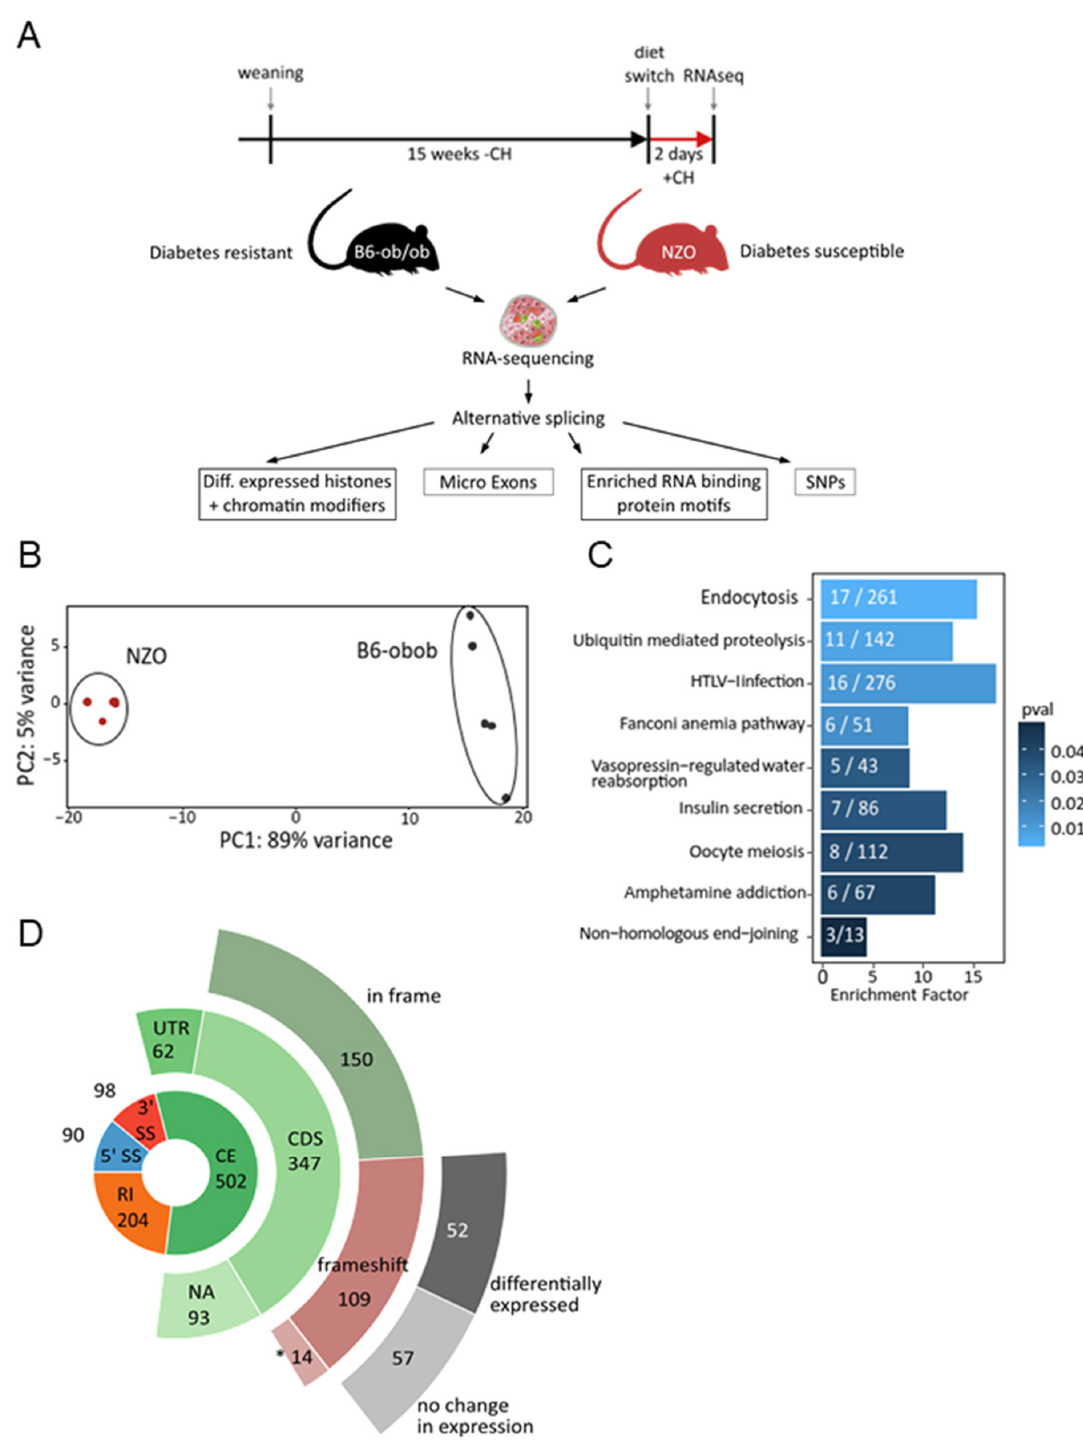
Figure 1. Alternative splicing in islets of NZO and B6-ob/ob mice. ( A ) Feeding regimen of B6-ob/ob and NZO mice, study design, and strategy of screening for alternative splicing. RNAseq analysis was performed after 2 days feeding with carbohydrates (+CH). ( B ) Principal component analysis of RNAseq data. ( C ) KEGG-pathway analysis of alternatively spliced genes. White numbers in bars indicate number of genes. ( D ) Donut plots of identified alternative splicing events and their respective consequences. 5 ′ ss = alternative 5 ′ splice site, 3 ′ ss = alternative 3 ′ splice site, CE = cassette exon, IR = intron retention. UTR = untranslated region, CDS = coding sequence, NA = not annotated. * Fourteen events have multiple di ff erential exons that might rescue the frame shift.